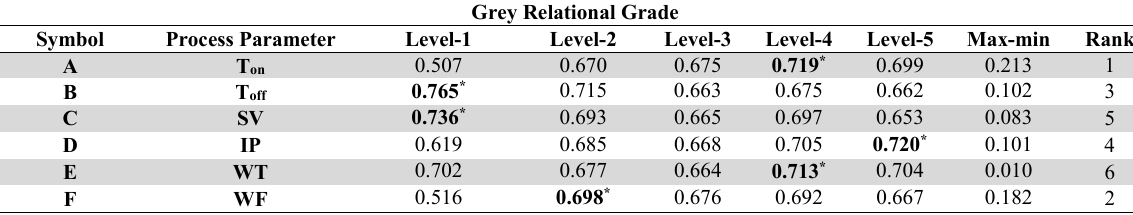
Response data for Grey Relational Grade